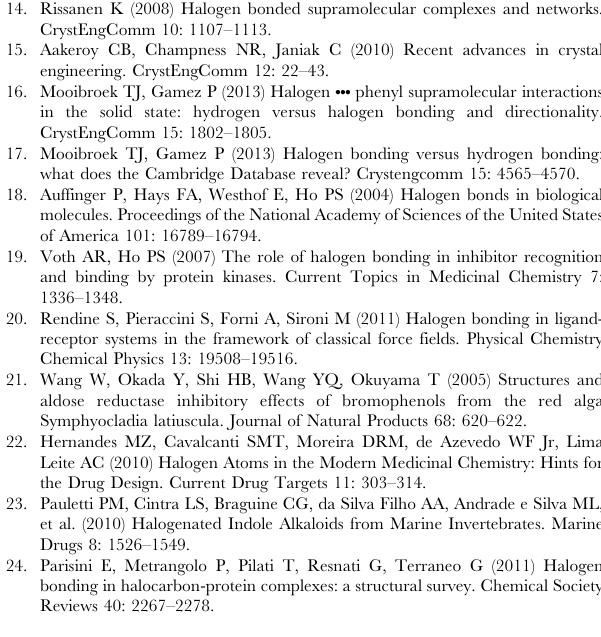
Table S1 Results of the Kruskal-Wallis (K-W) test in the analysis of the topology-dependent length of a hydrogen bond: for each pair of hydrogen bond acceptor/donor pair the p-value for the null hypothesis that both distributions are identical was estimated according to the two-tailed multiple comparison. The values marked in bold denote the pairs of distributions that differ one from the other, with a =0.05. Additionally, the identified number of each type of hydrogen bond, n, and mean rank test are presented. Table S2 Comparison of distributions of hydrogen bond lengths, calculated separately for halogenated but not fluorinated (LX), fluorinated (LF), and non-halogenated ligands (LH), for eight possible topologies of protein-ligand hydrogen bonds. Those for which hydrogen bonds to LX/LF ligands are, according to the Mann-Whitney U test, significantly shorter (assuming a = 0.05) are highlighted. Note that for each pair of H-bond distributions, a smaller mean rank indicates statistically shorter donor-acceptor distances, or, equivalently, positive values of Z U statistics indicate these types of H-bonds, which are longer to nonhalogenated ligands. The corresponding medians, and their differences with statistical significances (p), are also presented. Table S3 Comparison of distributions of hydrogen bond lengths, calculated separately for ligands fluorinated (LF), otherwise halogenated (LX), and non-halogenated (LH), for hydrogen bonds between ligand and protein that were identified in high-resolution X-ray